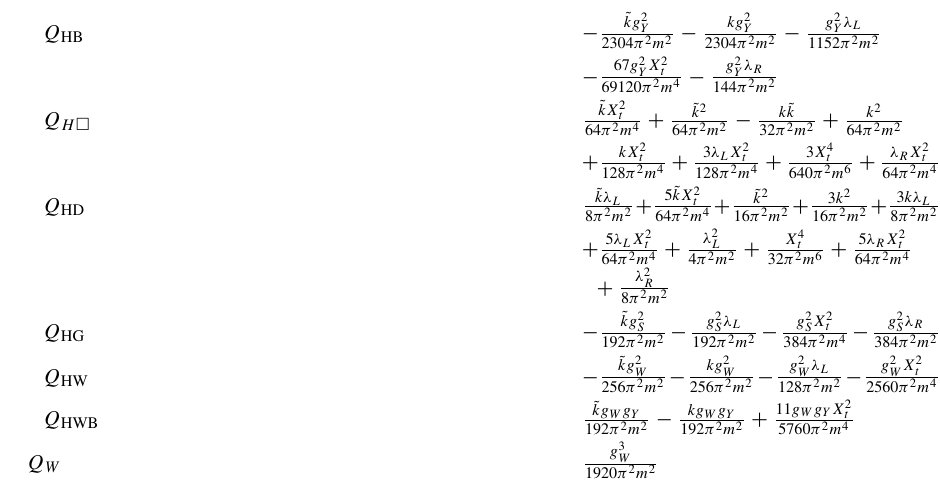
Table 12 Dimension-6 operators in “Warsaw” basis Scalar Q lq ( 1 )